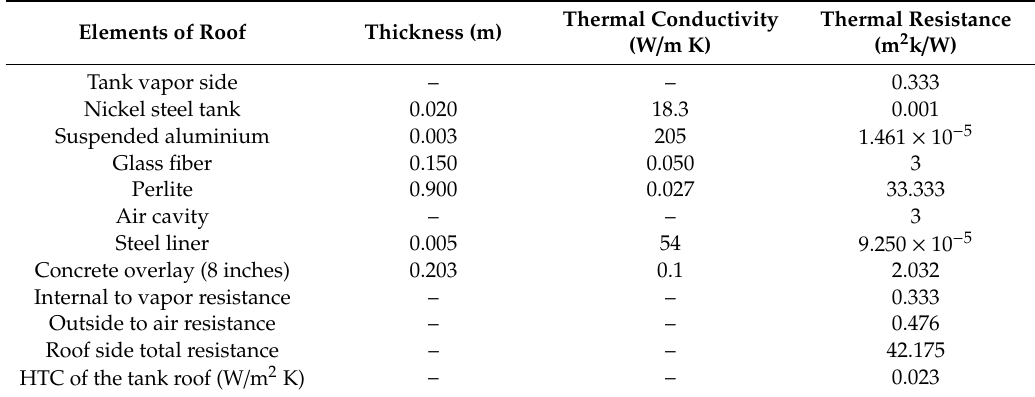
Table 3. Elements of the LNG tank roof design.